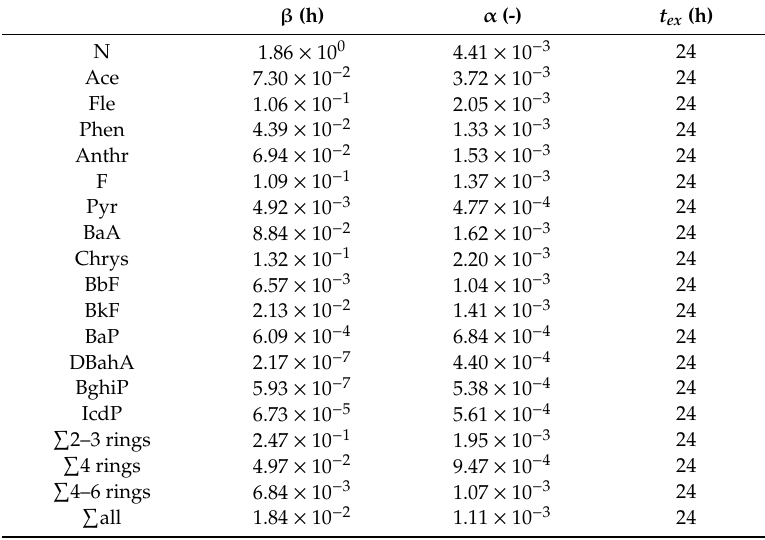
Table 3. Fitted parameters of the site distribution model for the di ff erent PAHs and t ex values calculated according to Equation (3).